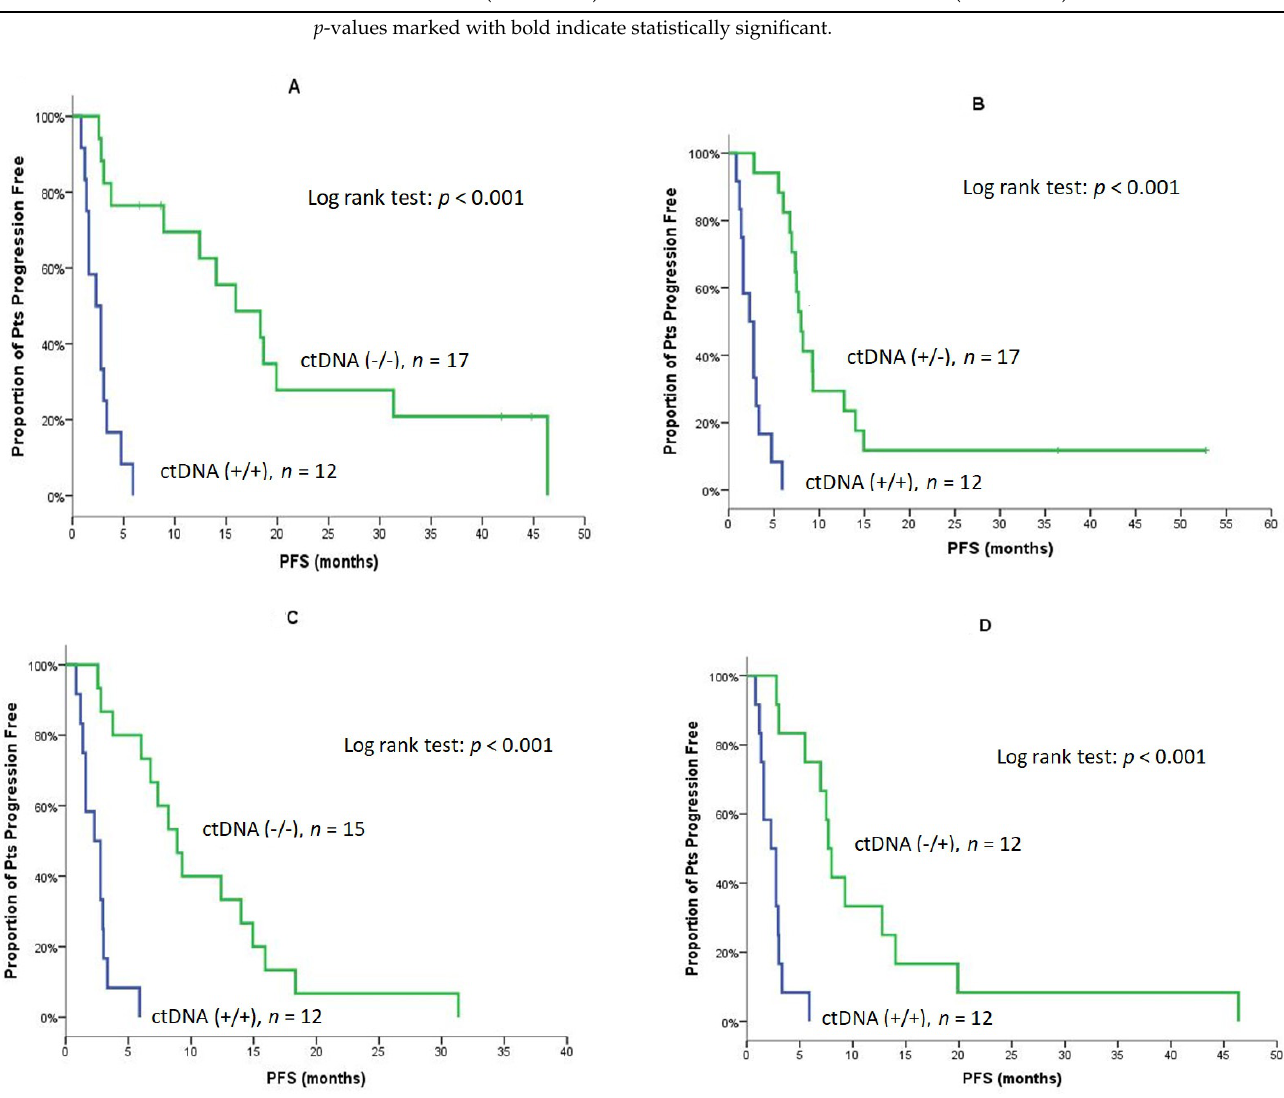
Figure 3. PFS of patients according to changes of ctDNA at Baseline, Post-1 and, at the EOT ( A ). Median PFS of patients with detectable ctDNA at Baseline and Post-1 [Pre (+)/Post-1 (+)] compered to those without detectable ctDNA at both time points [Pre ( − )/Post-1 ( − )]. ( B ) Median PFS of patients with detectable ctDNA at Baseline and Post-1 [Pre (+)/Post-1 (+)] compared to those with detectable ctDNA at baseline and non-detactable ctDNA Post-1 [Pre (+)/Post-1 ( − )]. ( C ) Median PFS of patients with detectable ctDNA Post-1 and at the EOT [Post-1 (+)/EOT (+)] compared to patients without detectable ctDNA at both time points [Post-1 ( − )/EOT ( − )]. ( D ) Median PFS of patients with detectable ctDNA Post-1 and at the EOT [Post-1 (+)/EOT (+)] compared to patients without detectable ctDNA at Post-1 and detectable ctDNA at the EOT [Post-1 ( − )/EOT